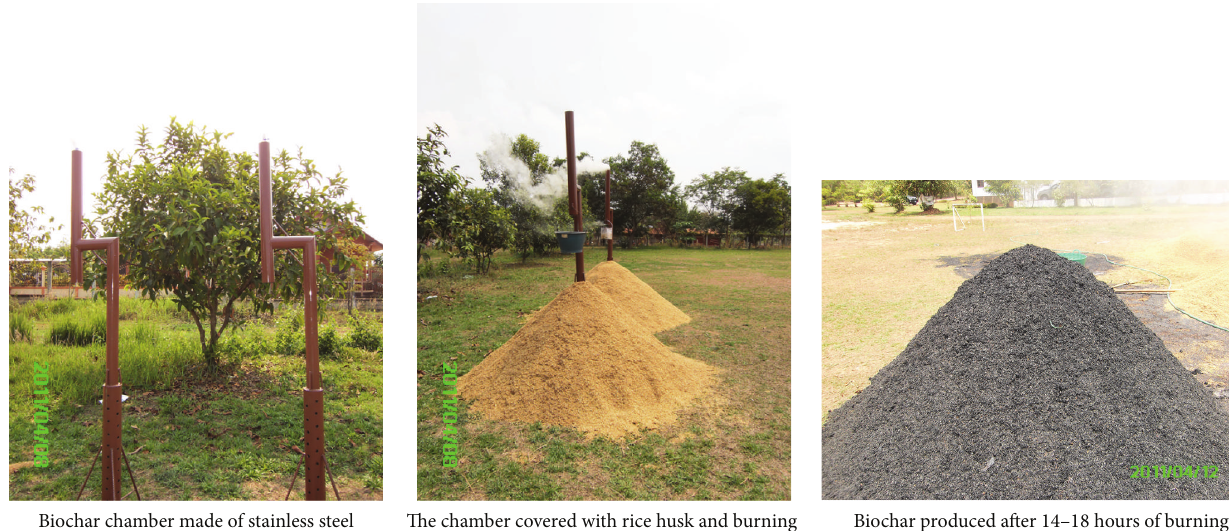
Figure 1: The process of biochar production using biochar chamber made of stainless steel from a rice husk (photo by Wolde Mekuria).